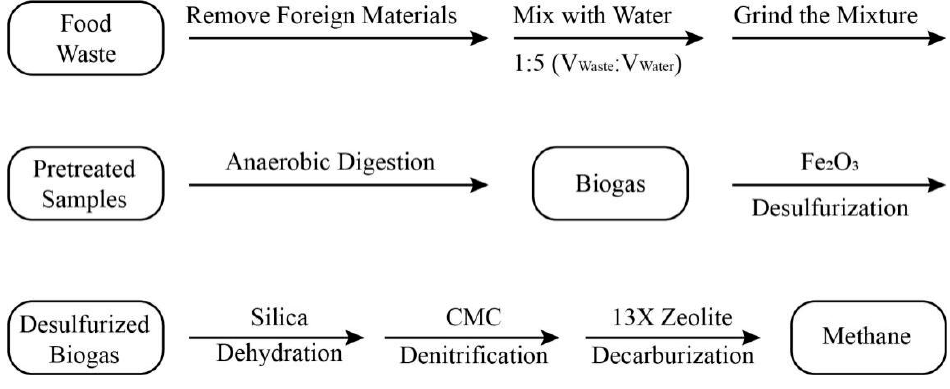
Figure 1. Method flow-process